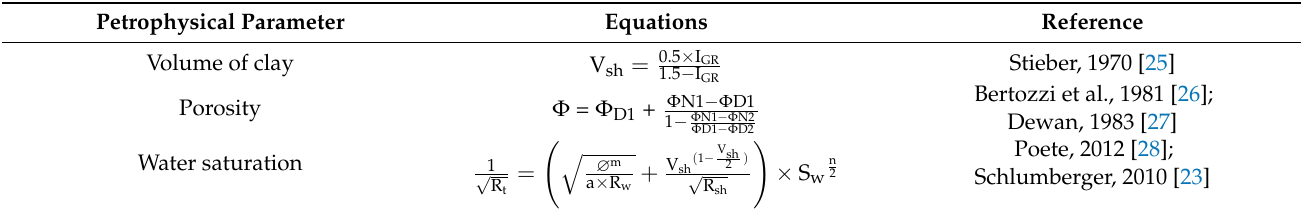
Table 1. A list of equations for petrophysical